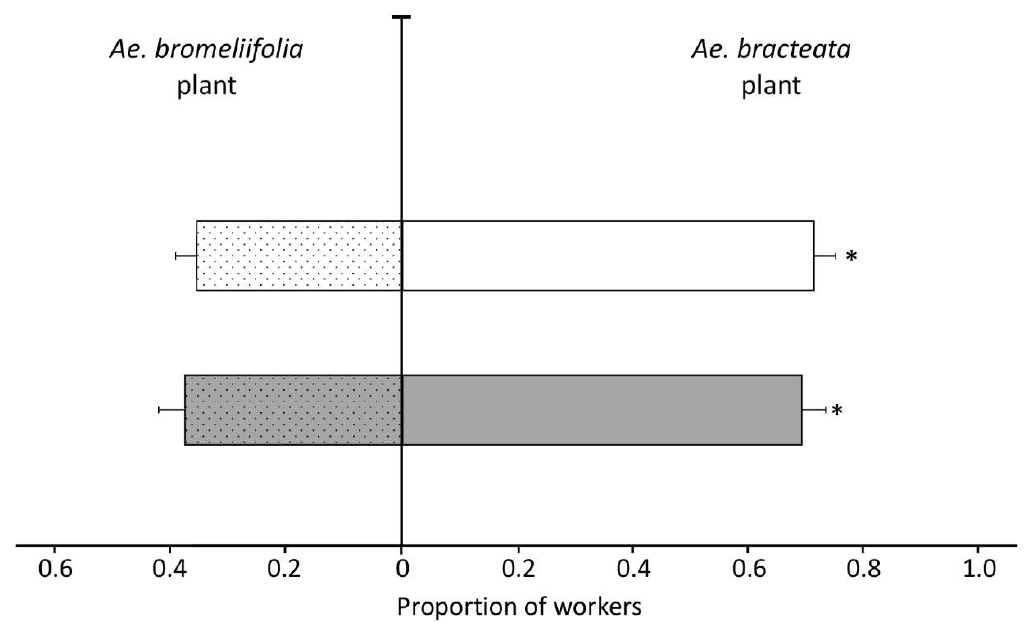
Figure 3. Mean proportion of N. villosa workers (± SEM ) in bioassays of whole plants of Ae. bracteata (empty bars) vs . Ae. bromeliifolia (dotted bars) of the same size. Bioassays were performed with two different experimental groups, i.e., workers originating from colonies originally nesting in Ae. bracteata (n = 30 trials, grey bars) and workers from colonies collected in tree cavities (n = 30 trials, white bars). * p ˂ 0.05, GLMM Wald χ 2 .